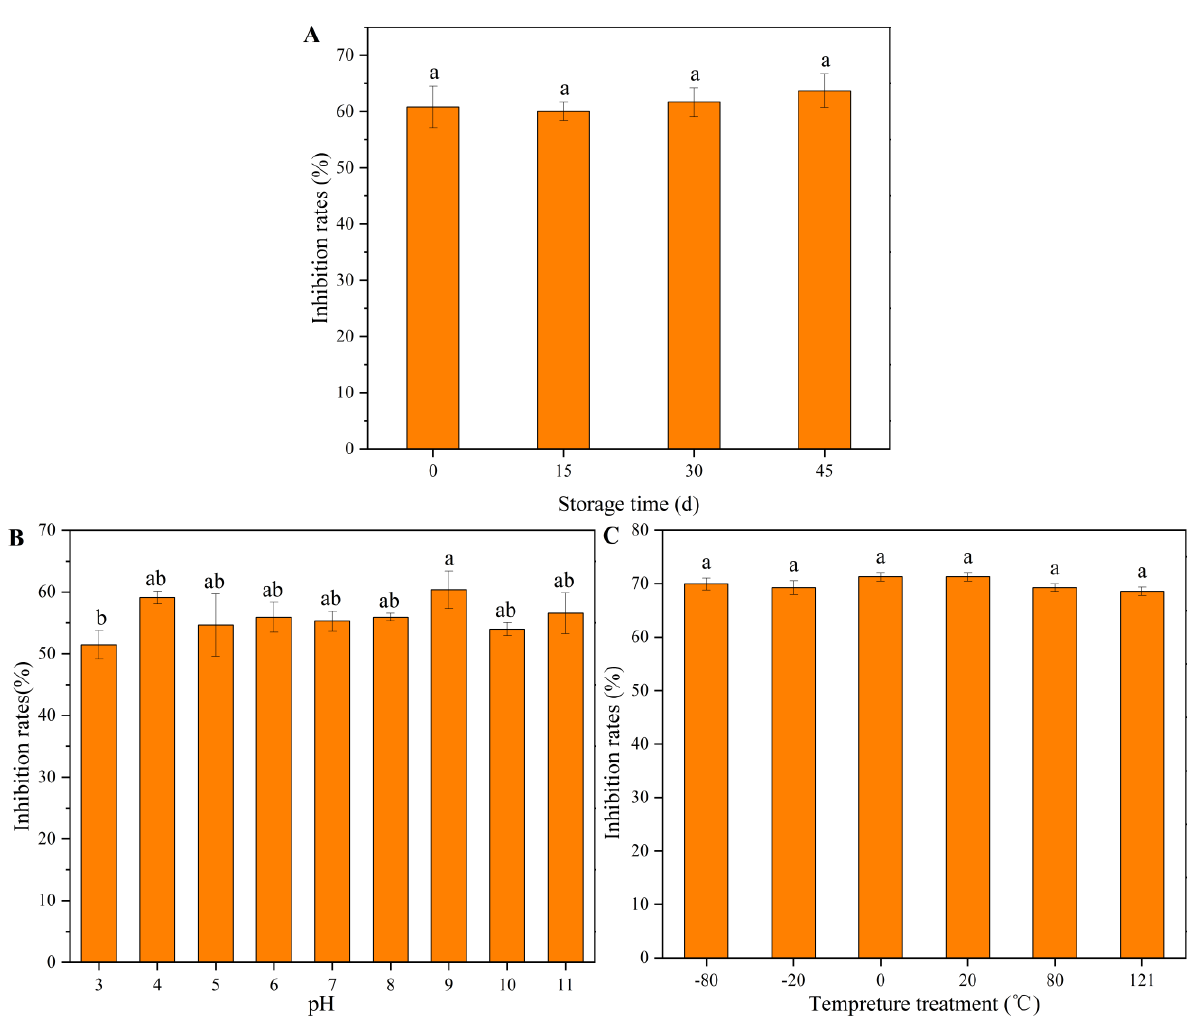
Figure 6. Stability of aseptic filtrate treated with different storage time ( A ), temperature ( B ), and pH values ( C ). Note: the aseptic filtrate concentration was 200 mL L −1 . Numerical values were expressed as mean ± SE of triplicates. The same lowercase letters indicate no significant difference between treatments ( p < 0.05).